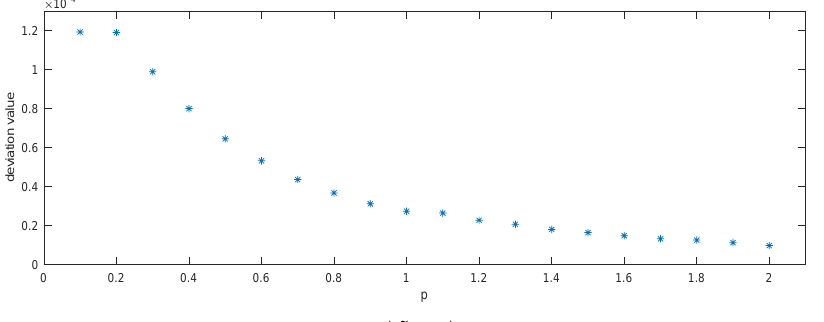
Figure 1. The deviation value of prices